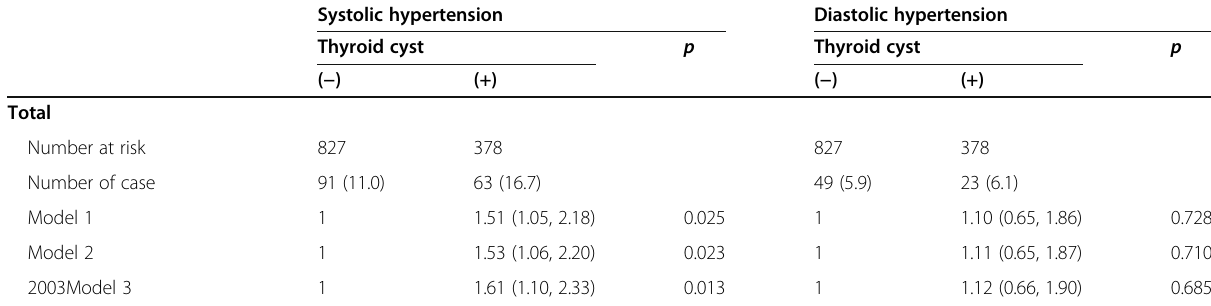
Table 5 Odds ratios (ORs) and 95% confidence intervals (CIs) for hypertension in relation to thyroid cyst among not-taking antihypertensive medication